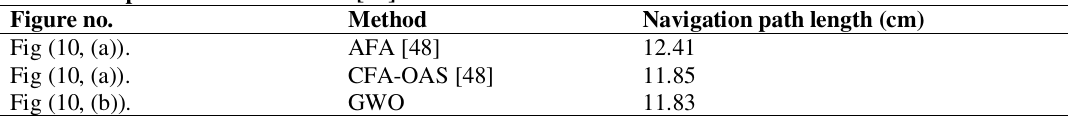
Results Comparison with reference [16]. Figure no. Method Navigation path length (cm) Fig (10, (a)). AFA [48] Fig (10, (a)). CFA-OAS [48] Fig (10, (b)). GWO